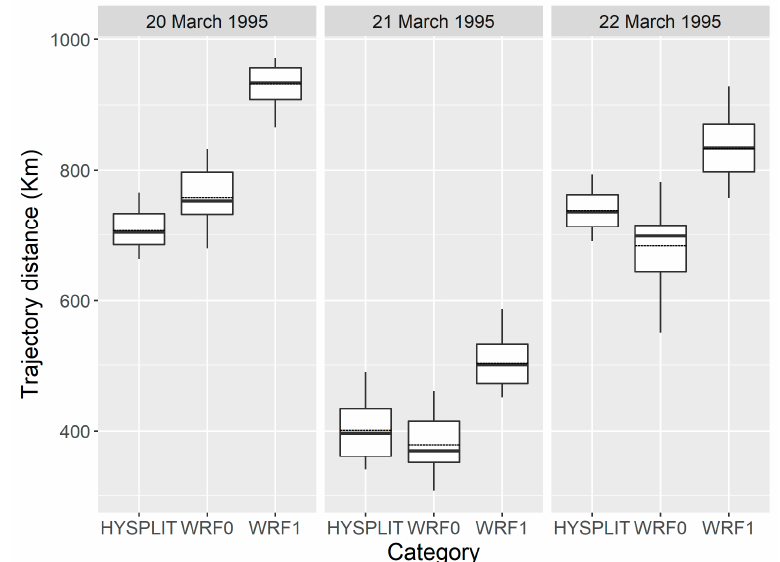
Figure 6. The distance from the starting source area to the endpoints of H. zea migration trajectories calculated by the HYSPLIT, WRF0 and WRF1, respectively. The bottom and top of the box indicate the lower and upper quartile values, respectively. The horizonal solid black line shows the median for each category, and the black dashed line represents the mean. Whiskers indicate the 5th and 95th percentiles.